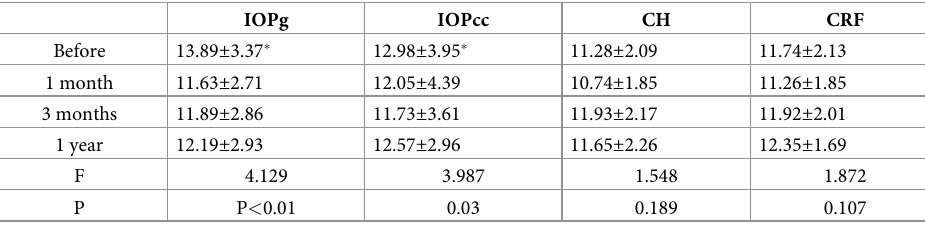
Table 3. Corneal Biomechanics before and after